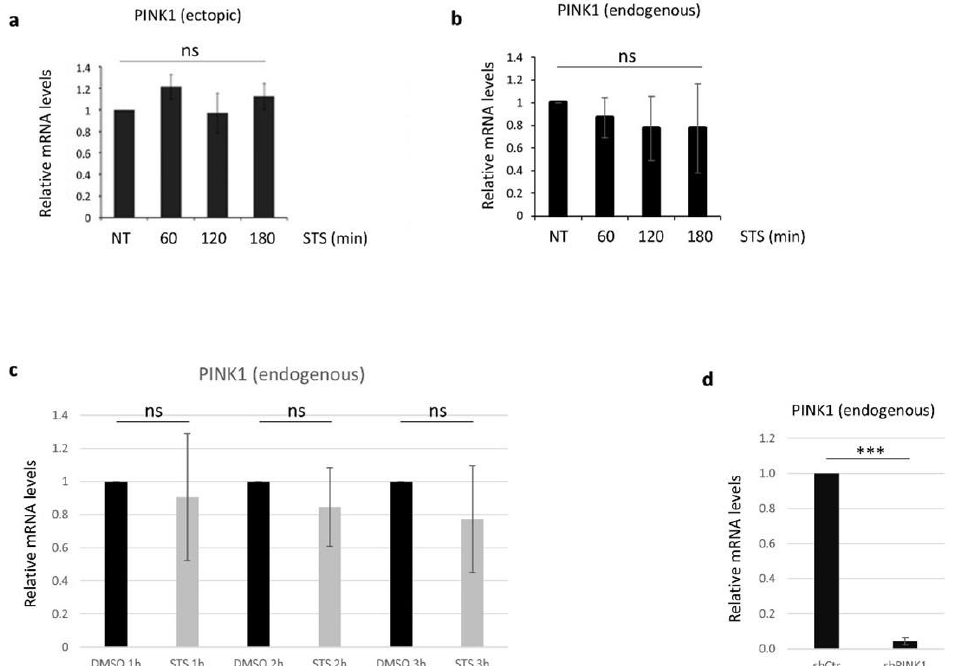
Figure A1. PINK1 gene transcription does not change significantly after STS exposure, while it is significantly reduced after shPINK1. ( a ) Analysis of PINK1 mRNA levels was performed by RT-qPCR in PINK1-overexpressing SH-SY5Y cells. We observed no significant differences in PINK1 transcript at the indicated times; ( b ) analysis of endogenous PINK1 mRNA levels was performed by RT-qPCR. We observed no significant differences in PINK1 expression after STS treatment for the indicated times. “NT” refers to cells treated for DMSO for 3 h; ( c ) the analysis of endogenous PINK1 mRNA by RT-qPCR did not show significant differences in a point-by-point comparison between SH-SY5Y cells treated either with DMSO or with STS for 1, 2, and 3 h; ( d ) PINK1 downregulation by shRNA (shPINK1) induces a significant reduction in endogenous PINK1 mRNA in SH-SY5Y cells. *** p ≤ 0.001. ns = not